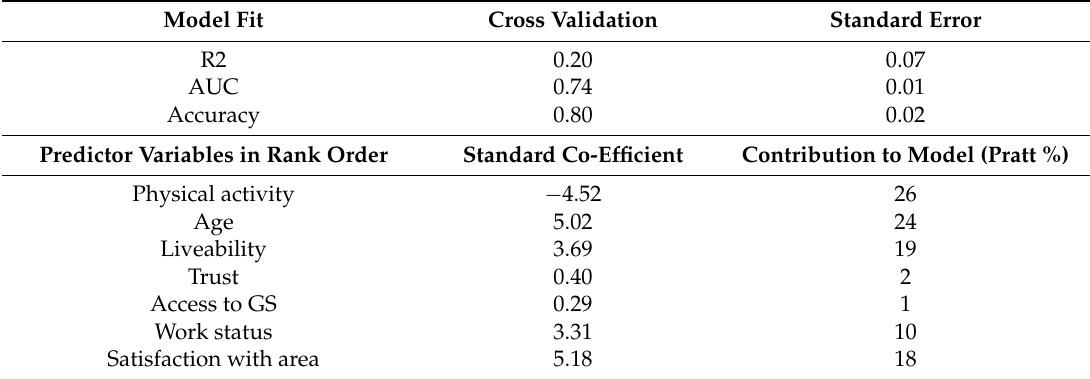
Table B1. CCR model fit and standard coefficients for predictors of “very good” general health, people of Indian